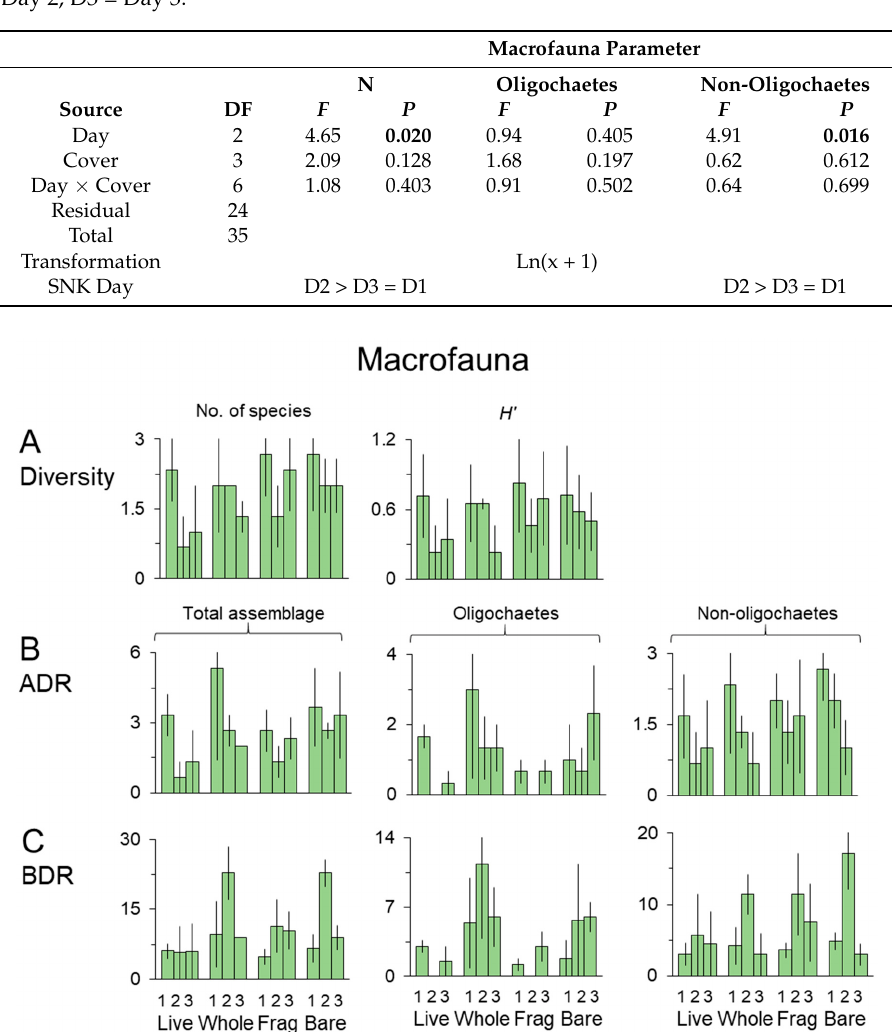
Figure 6. ( A ) Macrofauna values for number of taxa and H’ in traps. ( B ) Macrofauna absolute dispersal rates (ADRs). ( C ) Meiofauna bulk dispersal rates (BDRs). Values are mean ± 1 SE. Live = live mussels, Whole = whole shells, Frag = fragmented shells, Bare = bare sediment. 1 = Day 1, 2 = Day 2, 3 = Day 3.